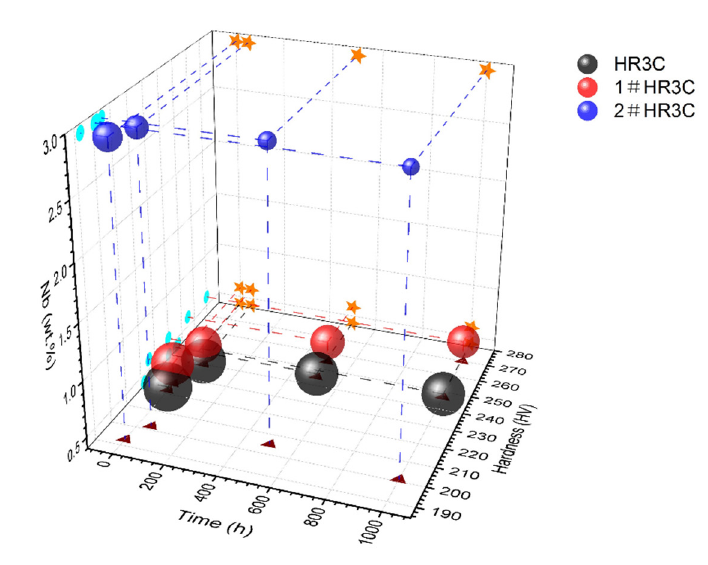
Figure 11. Variations of the average grain sizes of the three groups of HR3C alloys after steam oxidation with the exposure time, where the extent radius represents the grain size in the alloys.